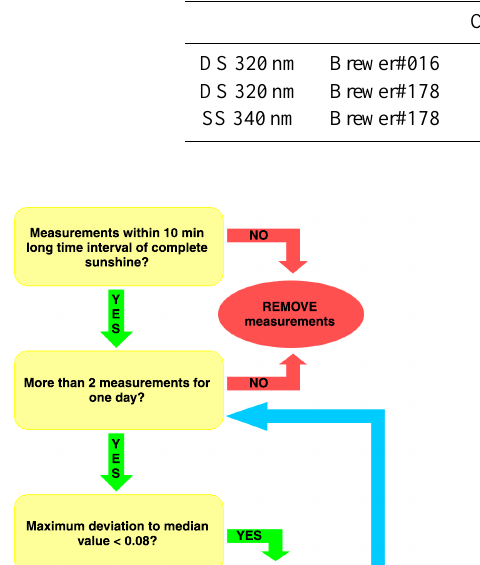
Table 1. Comparison of Brewer and Cimel aerosol optical depth values (2006–2013).